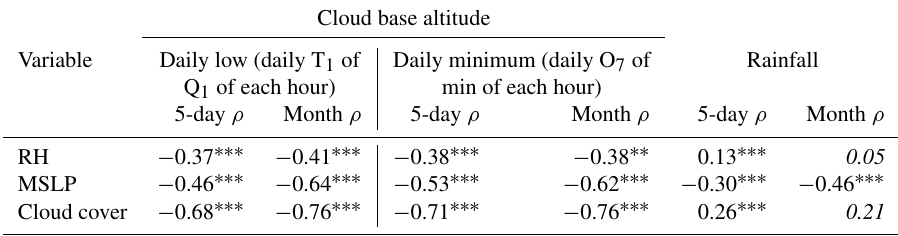
Table 2. Correlations coefficients ρ of relative humidity (RH), mean sea level pressure (MSLP), and cloud cover with cloud base altitude metrics and rainfall in the Luquillo Experimental Forest.